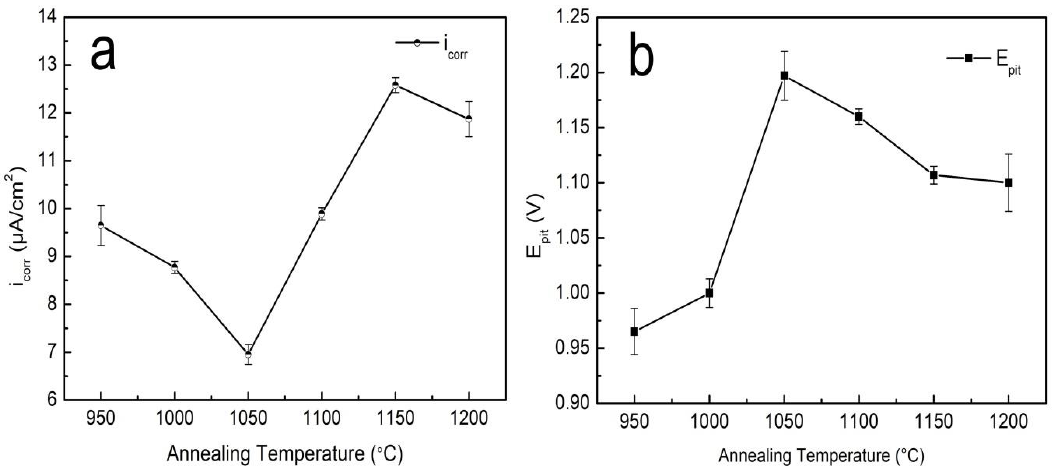
Figure 6. Polarization curves of S32750 stainless steel at different annealing temperatures.